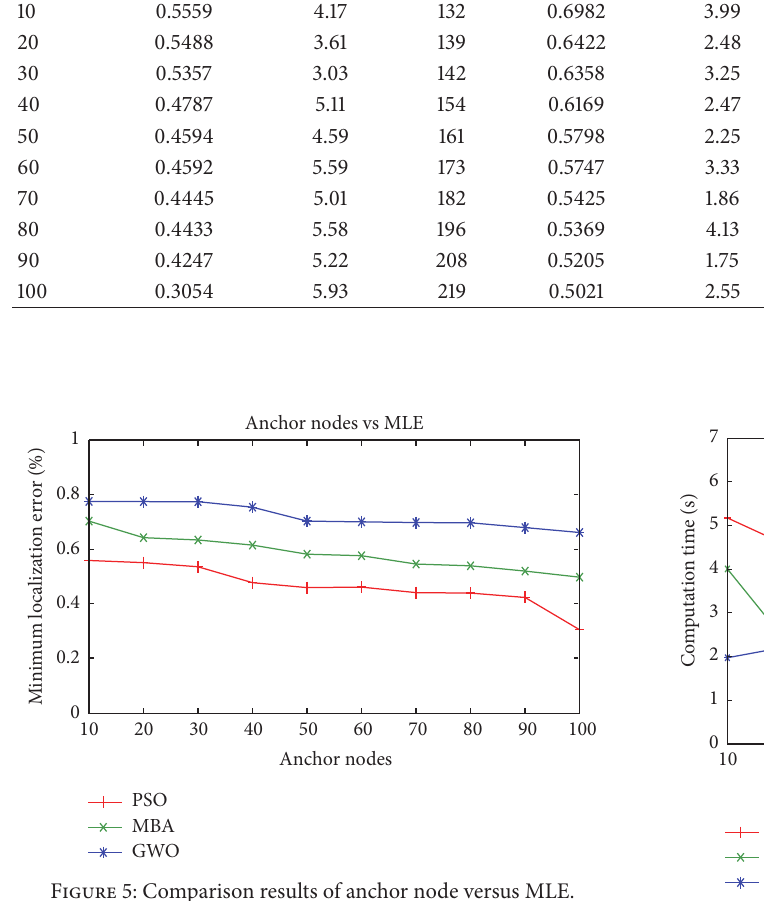
Figure 6: Comparison results of anchor node versus computation Time.